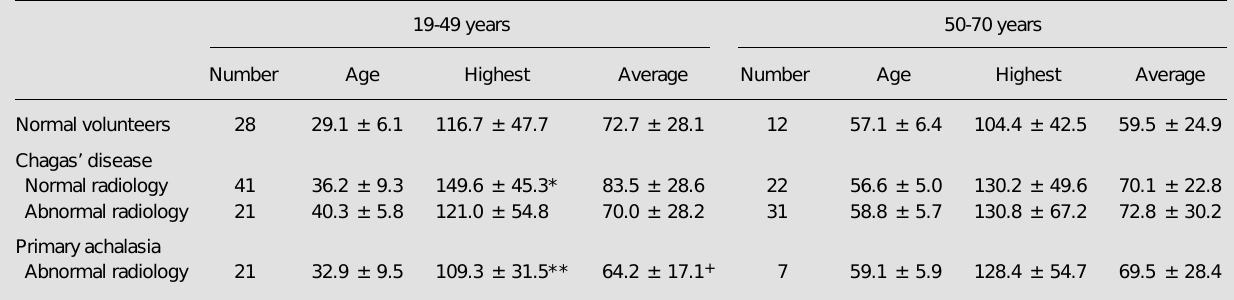
Table 3 - Effect of age on upper esophageal sphincter pressures (mmHg) of two groups of normal volunteers, patients with Chagas’ disease and patients with primary achalasia, measured at the site with the highest pressure and as the average of the four sites where the pressures were measured. Data are reported as mean ± SD. *P<0.05 vs volunteers; **P<0.01 vs Chagas with normal radiology; + P<0.05 vs Chagas with normal radiology (Tukey-Kramer